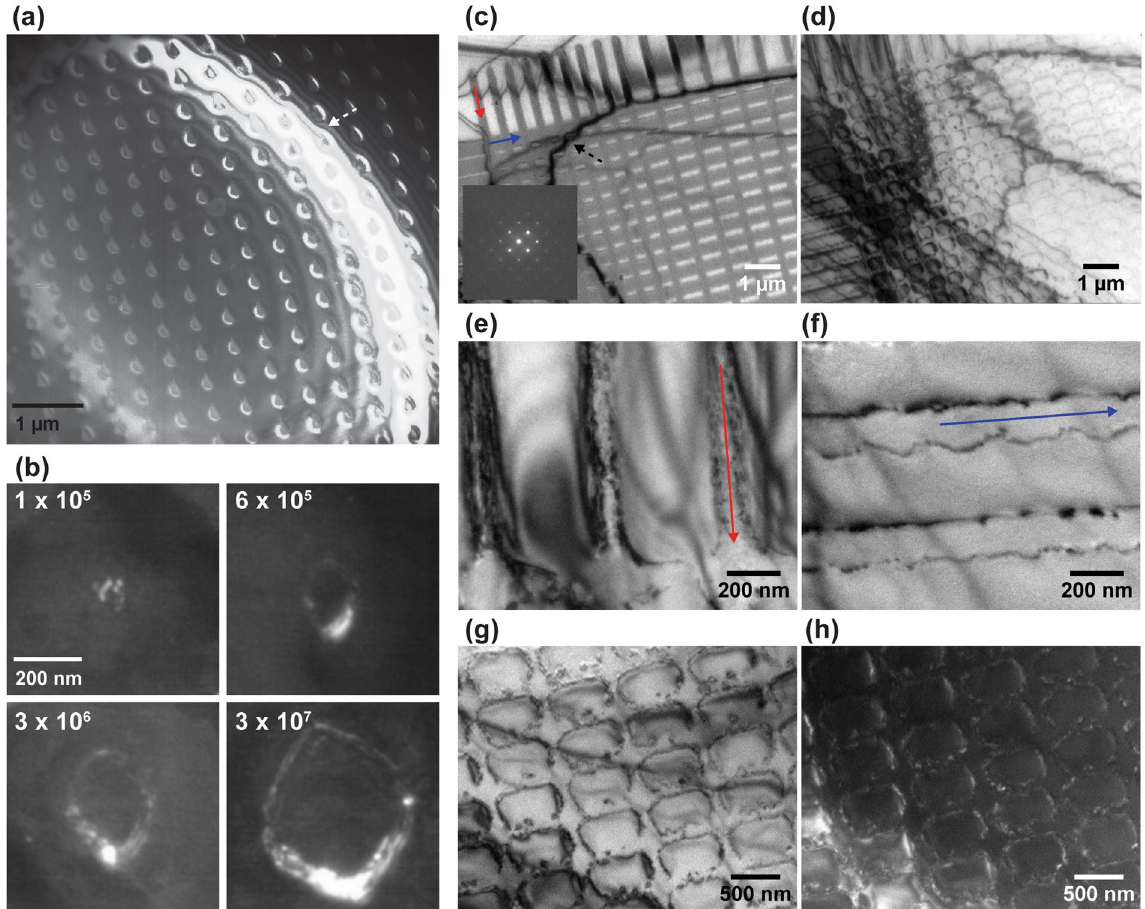
Figure 4. ( a ) Dark field TEM of an array of amorphous spots (5 × 10 4 ions per spot) formed by 60 keV Si 2 + ion implantation into a 220 nm thick Si(001) membrane. The bright bands (white dotted arrow) in the image are bend contours caused by membrane buckling. ( b ) Dark field TEM of the residual defects formed in the substrate by implantation at the doses shown followed by anneal in situ at 600 °C. ( c ) Bright field TEM of amorphized lines generated by implanting a row of closely spaced spots. The dose per spot is 1 × 10 5 ions and the distance between spots is 50 nm. Note the different width of the two sets of lines, ~210 nm for top to bottom lines (red arrow) and ~350 nm for left to right lines (blue arrow), attributed to astigmatism of the FIB spot. The lines were patterned without specifying an orientation with respect to the substrate crystal; inset is the Si diffraction pattern. The dark bands (black dotted arrow) are bend contours caused by membrane buckling. ( d–f ) Bright field images recorded after heating in situ to 600 °C showing recrystallization and residual line defects that track the original pattern. ( d ) shows the area in ( c ) and ( e , f ) are higher magnification images showing the defects along each set of lines. ( g , h ) Bright and dark field images of an area near the center of the grid pattern. The bright field image is taken close to the [001] zone axis and the dark field image with a {400} diffraction